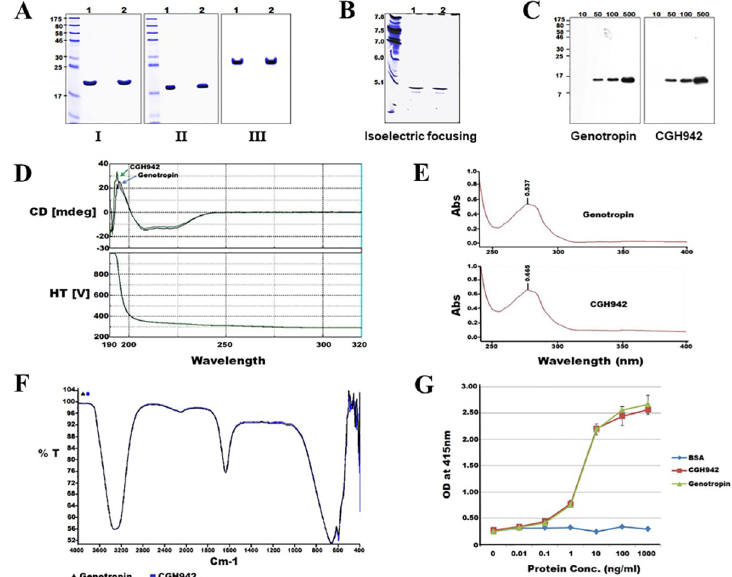
Fig 5. Characterization of purified protein from porcine milk. (A) Electrophoresis I: SDS-PAGE gel (+DTT, reducing), II: SDS-PAGE (-DTT, non-reducing), III: Native gel, 1: Genotropin, 2: CGH942. (B) Isoelectric focusing gel, 1: Genotropin, 2: CGH942. (C) Western blotting. The gel was loaded with 10 ng, 50 ng, 100 ng, and 500 ng rhGH per lane. (D) Circular dichroism spectropolarimeter, HT[V]: High tension voltage. (E) Ultra violet spectrum, Abs: absorbance. (F) Fourier Transform-Infrared (FT-IR) spectrum. (G) Cell proliferation of Nb2-11 cells after rhGH treatments.